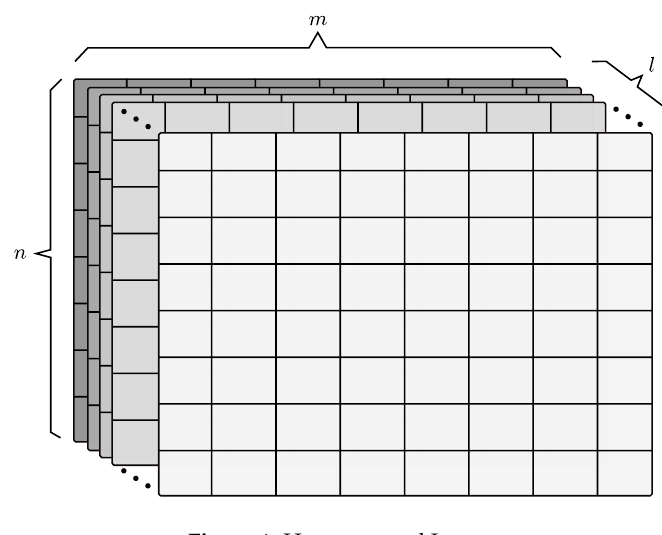
Figure 1. Hyperspectral